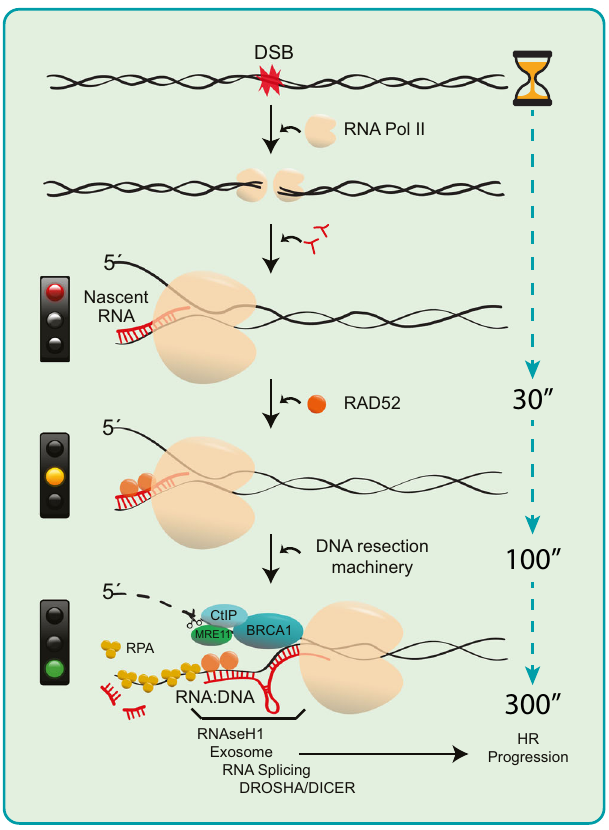
Fig. 7 | Schematic model of the regulation and role of RNAPII-generated nas- cent RNA to guide DNA end resection and DSB repair by HR. Transcriptionally activeRNAPIIismoreprominentinS-G2cellcyclephases(showedinFig.1)whenHR is known to repair DSBs. RNAPII recruitment to DSBs, that involves the pre- initiation complex (PIC) 23 , favors nascent RNA transcription, leading to generation of small RNA:DNA hybrid structures that cause RNAPII pausing (showed in Figs.2, 3). RAD52 and XPG are capable of rescuing the transiently paused RNAPII activity (8), allowing for 5 ’ DNA strand displacement. Experimental inhibition of transcrip- tion impairs recruitment of the DNA resection factors CtIP, MRE11 and BRCA1 (showed in Figs.4, 5) to DSBs. MRE11 initiates 5 ’ strand degradation, while the CtIP- BRCA1 axis is essential to regulate the speed of resection 23 by controlling tran- scription upon DNA damage (showed in Fig.6). We show that CtIP and BRCA1 are factors promoting and/or re-starting the locally paused RNAPII-mediated tran- scription. These upstreamevents guide the DSBrepairchoicetowards HRthrough initiationandprogressionofDNAendresection,inafeedbackloopinwhichproper